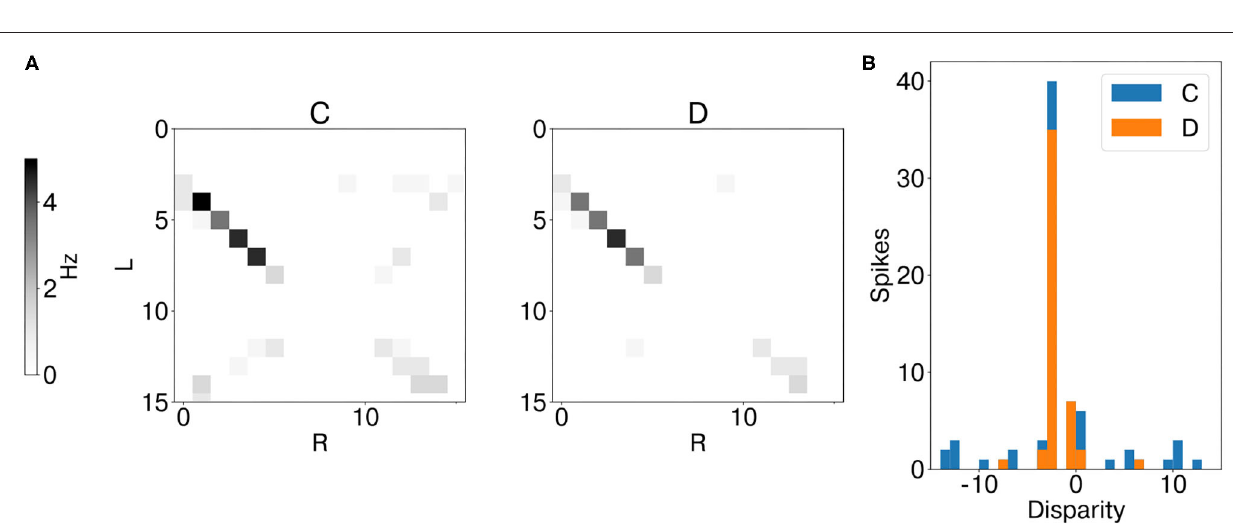
FIGURE 9 | Results of network emulation with event camera dataset from network layer L2. Mean firing rate of coincidence neurons (C, excitatory population) and disparity population (D) (A) . Histogram of encoded disparity value across the trial duration in both coincidence (blue) and disparity neurons (orange) (B) . As the activity clusters around the true disparity values, the disparity population successfully resolves the stereo